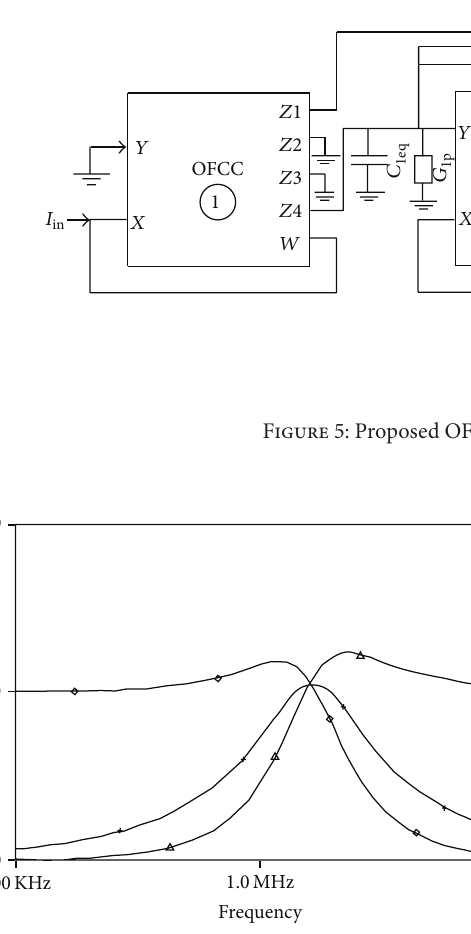
Figure 8: Magnitude and phase plots for all-pass response.